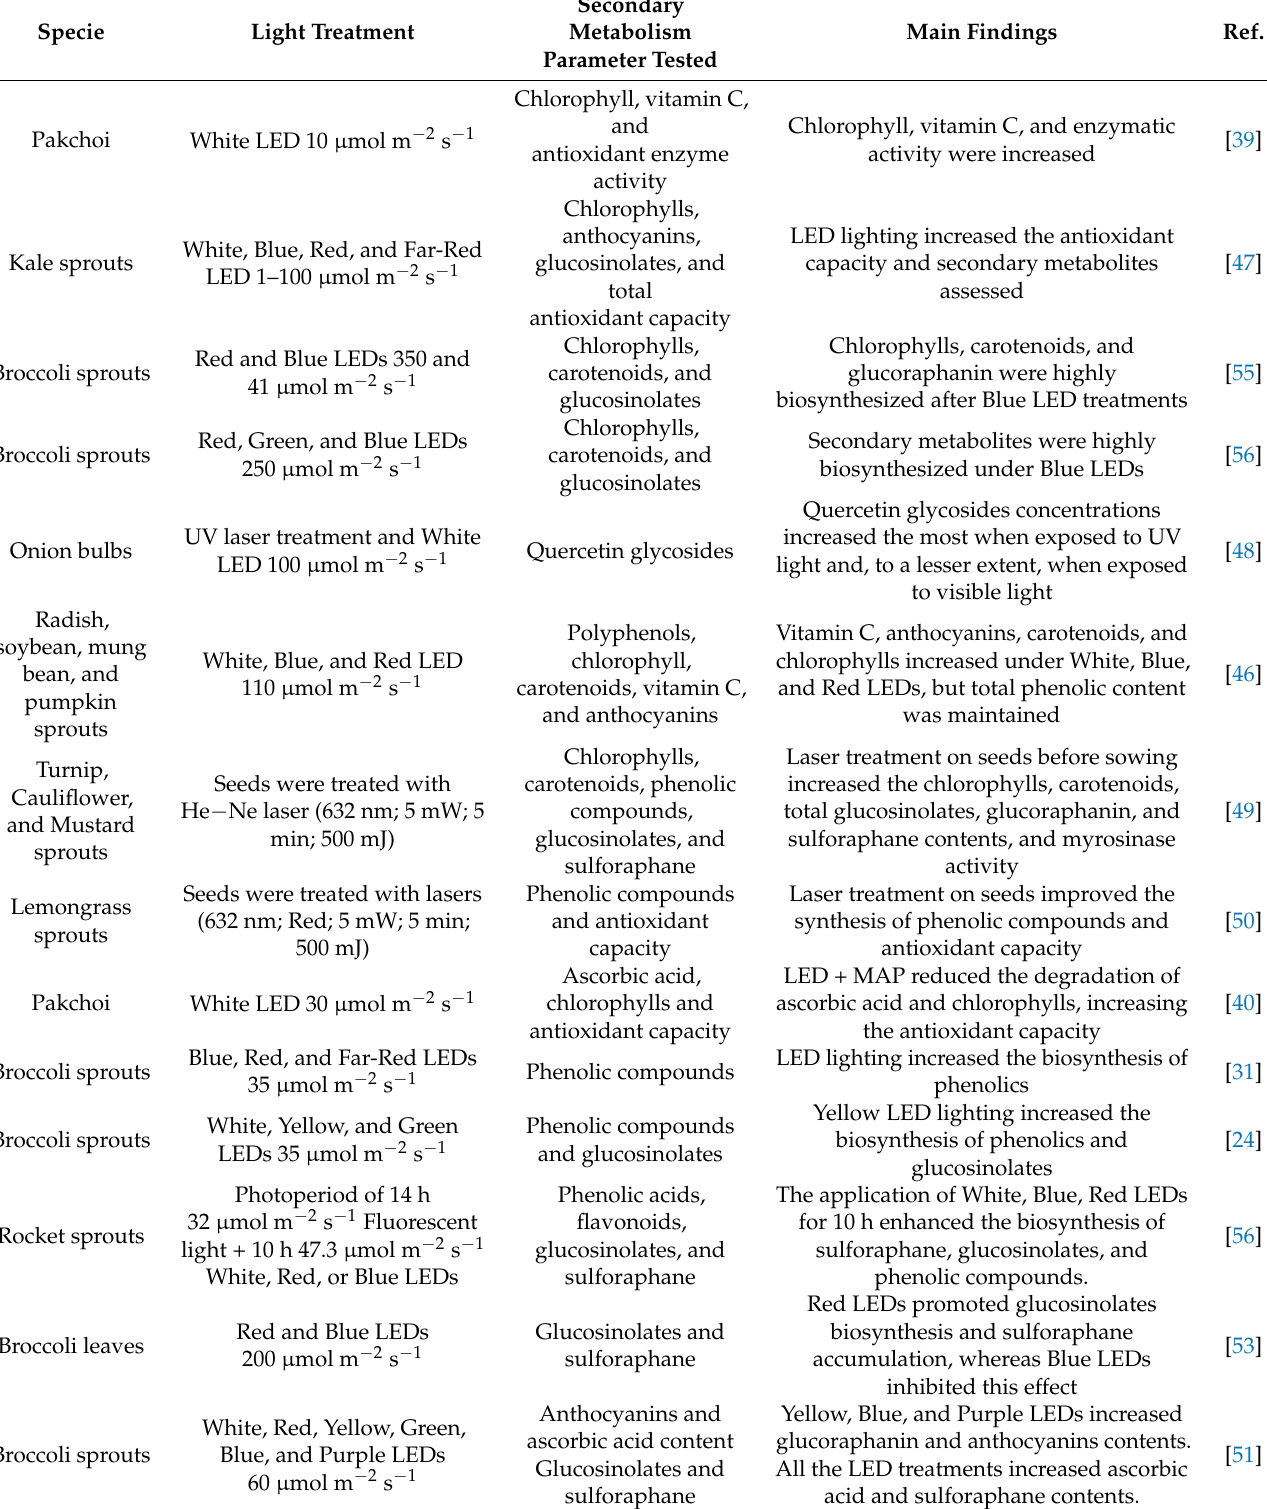
Table 3. State-of-art of main effects regarding sprout secondary metabolism under different illumina- tion wavelengths from the visible